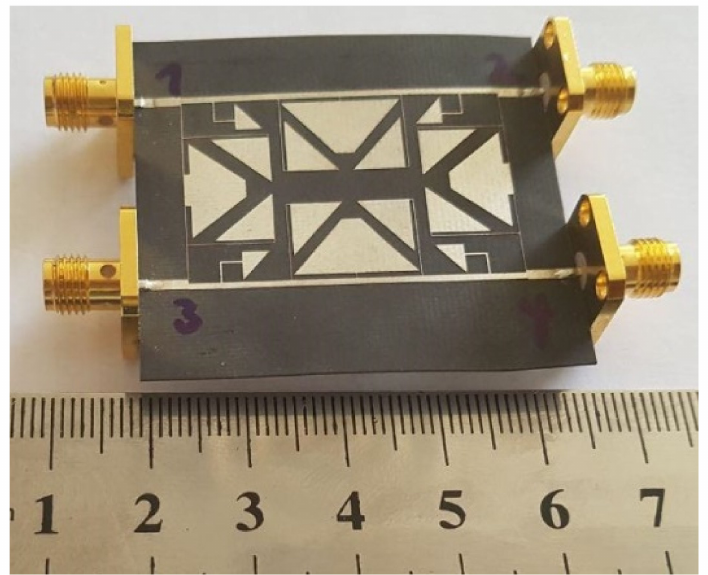
Figure 15. Photograph of the fabricated BLC.